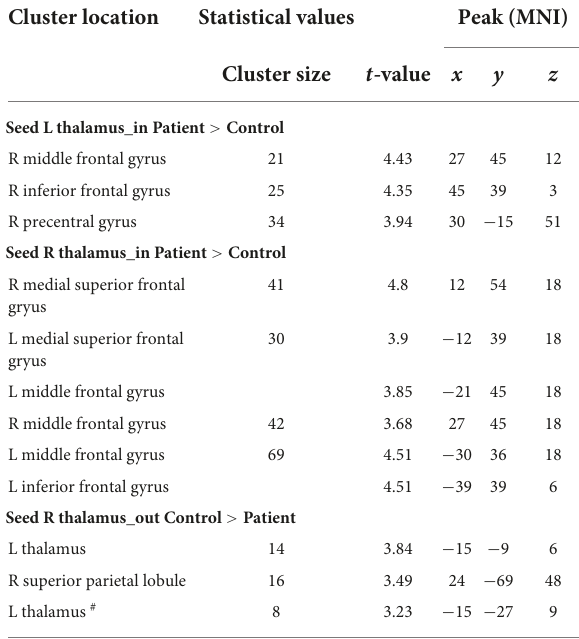
TABLE 4 Significant group differences in dEC analysis.